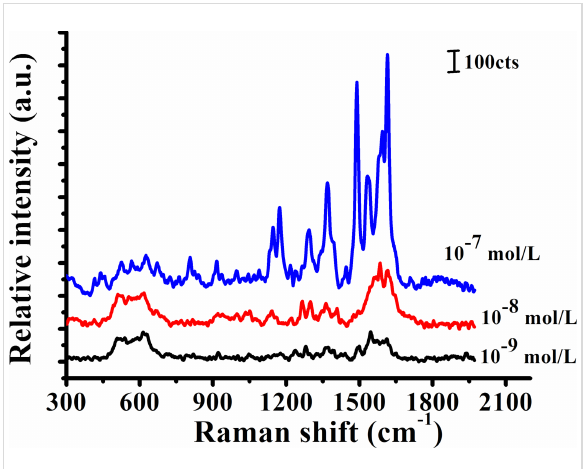
Figure 12: Raman spectrum of MG molecules at different concentra- tions on Ag/Cu substrates.